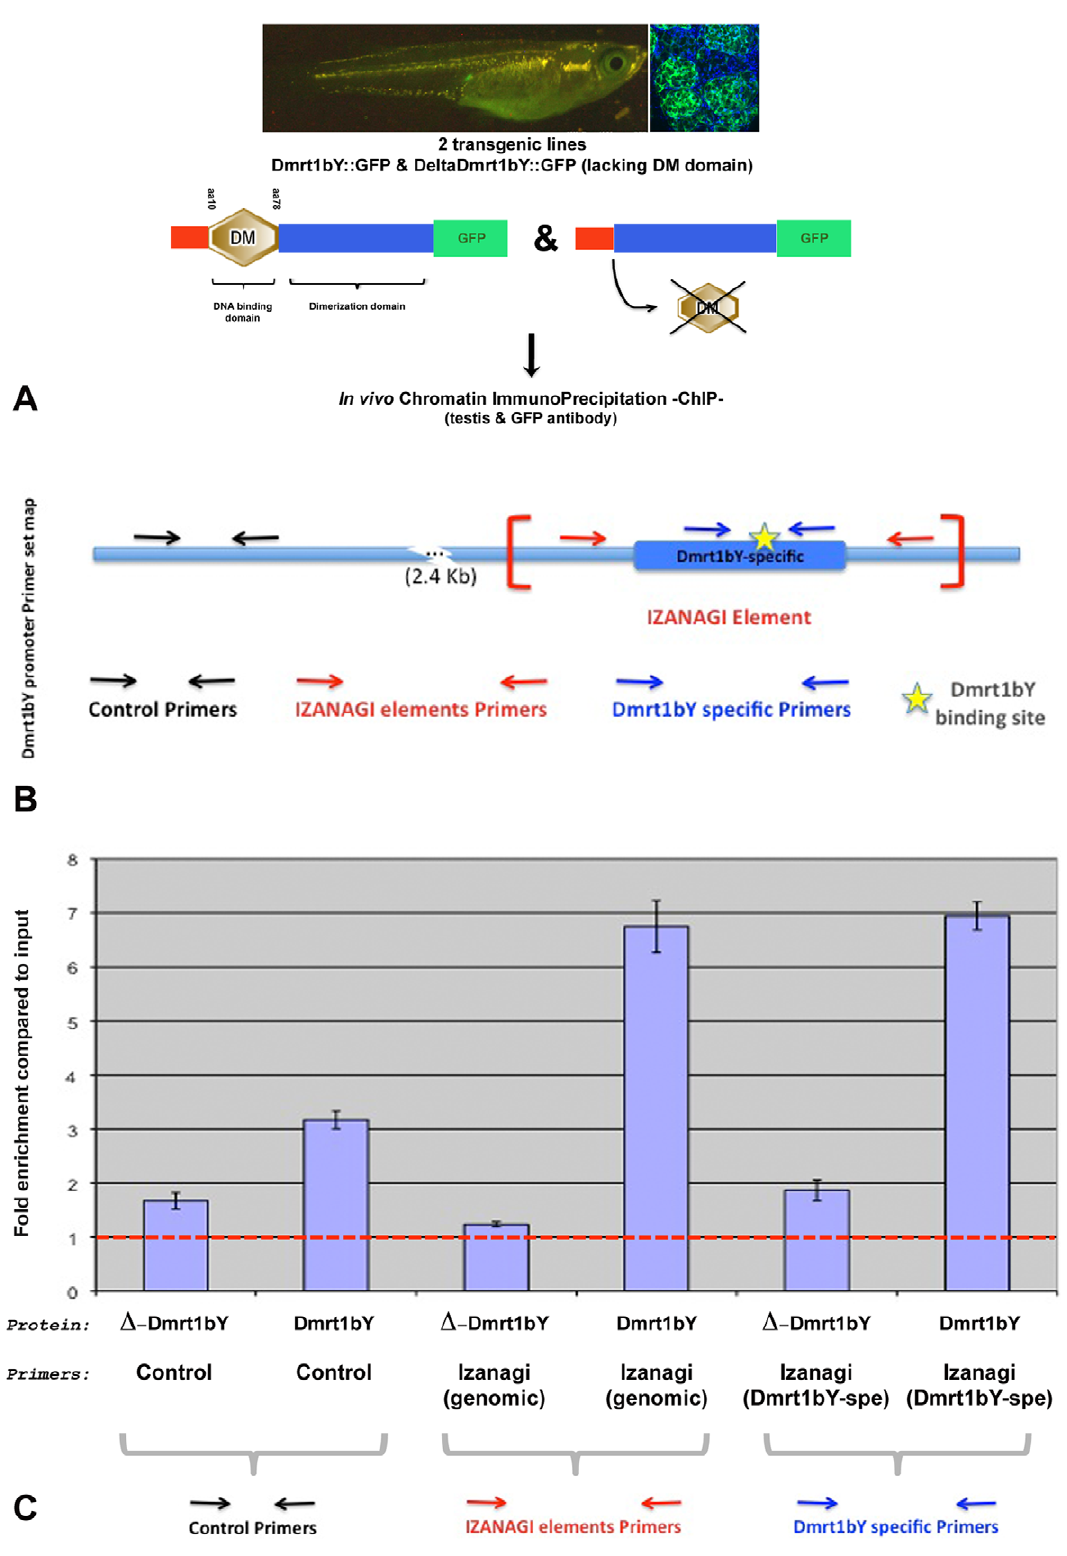
Figure 6. Tissue Chromatin immunoprecipitation (Tissue–ChIP) of Dmrt1bY binding to the Izanagi -nested Dmrt1 target site. Chromatin immunoprecipitation using both Dmrt1bY::GFP and deltaDmrt1bY::GFP transgenic lines respectively expressing either Dmrt1bY or a control truncated Dmrt1bY (delta DM form lacking the DNA binding domain) fused to GFP revealed specific in vivo Dmrt1bY protein affinity to the Izanagi -nested dmrt1 target site, including the one described within dmrt1bY promoter. (A) Transgenic lines established for in vivo tissue–ChIP. (B) Dmrt1bY promoter primer sets map. (C) Specific enrichment of Izanagi -nested Dmrt1 binding sites subsequent to in vivo Dmrt1bY immunoprecipitation.